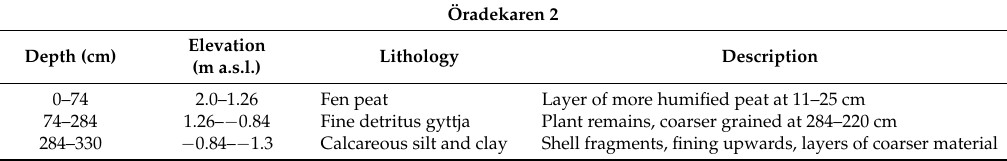
Table 3. Lithostratigraphy of the Öradekaren 2 sediment sequence. 14 C dates are listed in Table